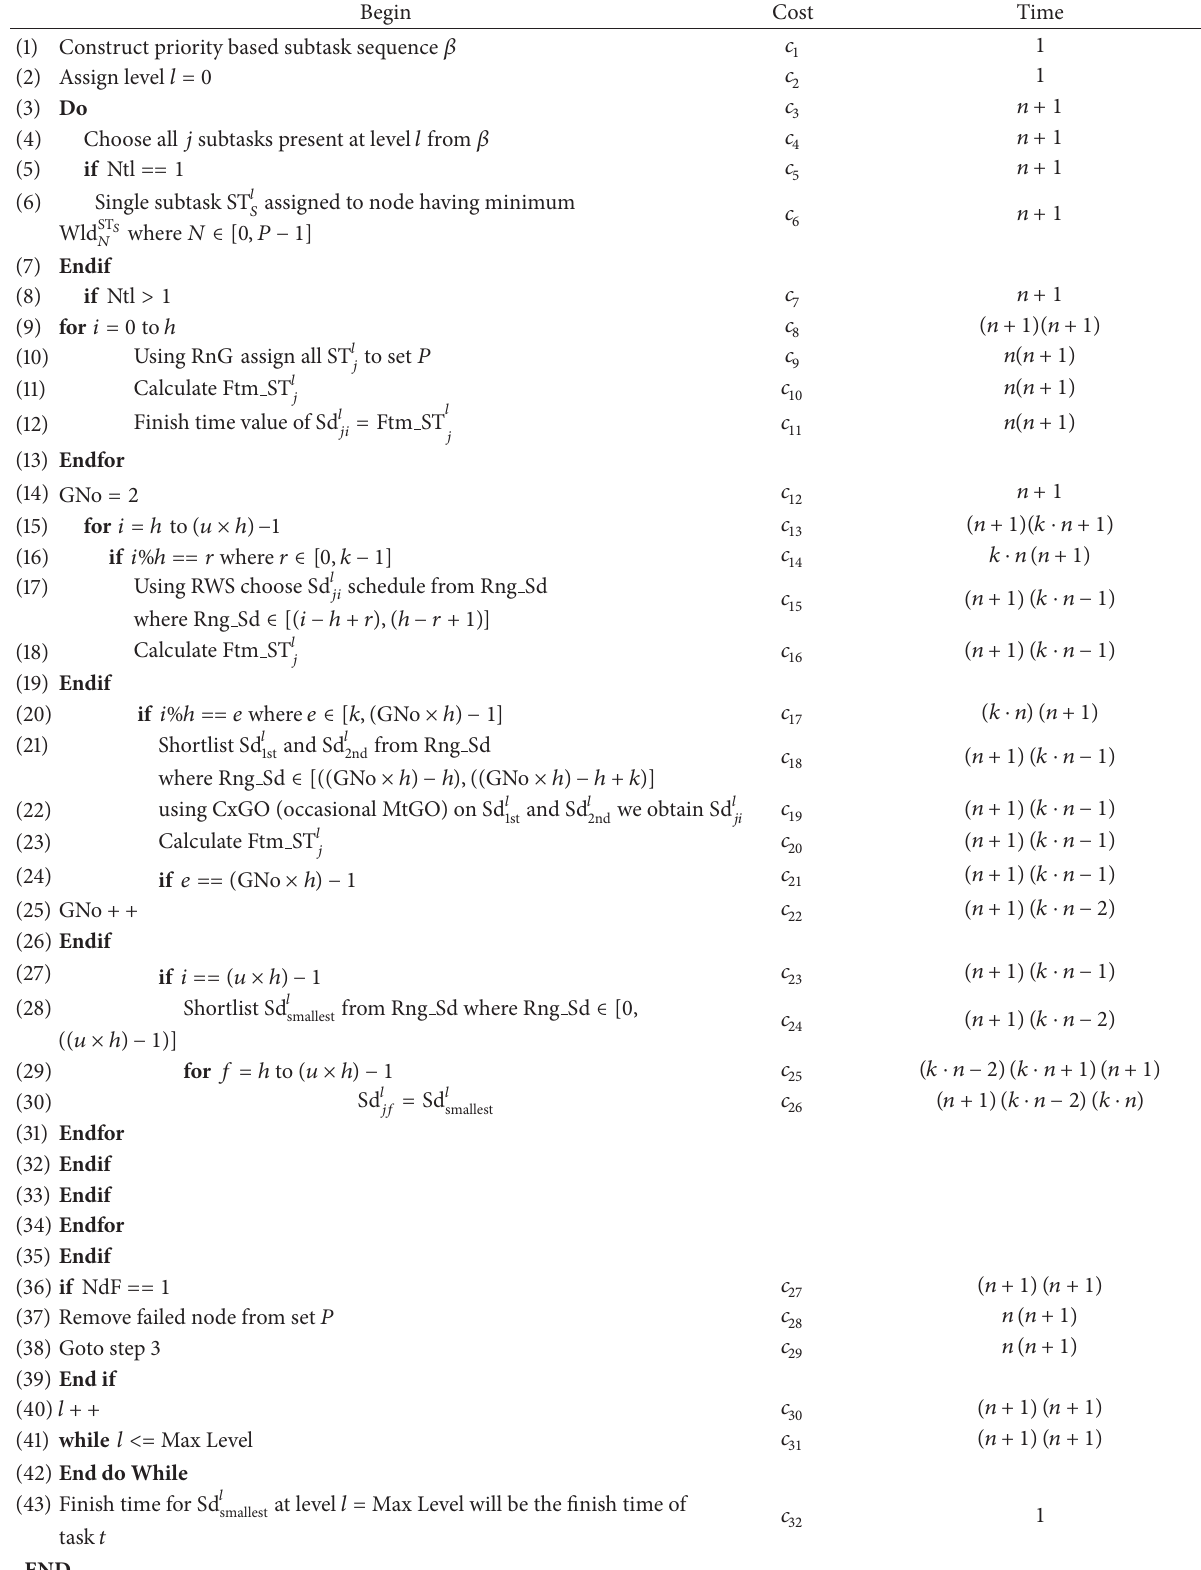
Table 1: Fault tolerant PLBGSA for P2P